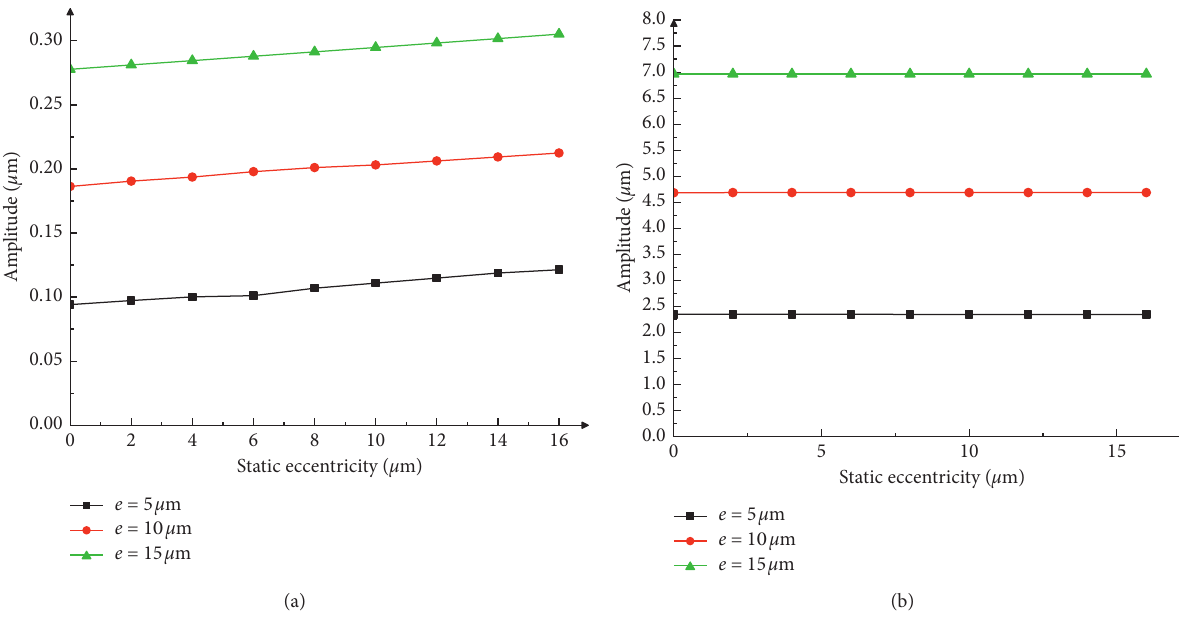
0.00.20.40.60.81.01.21.41.61.82.02.22.42.62.83.03.2